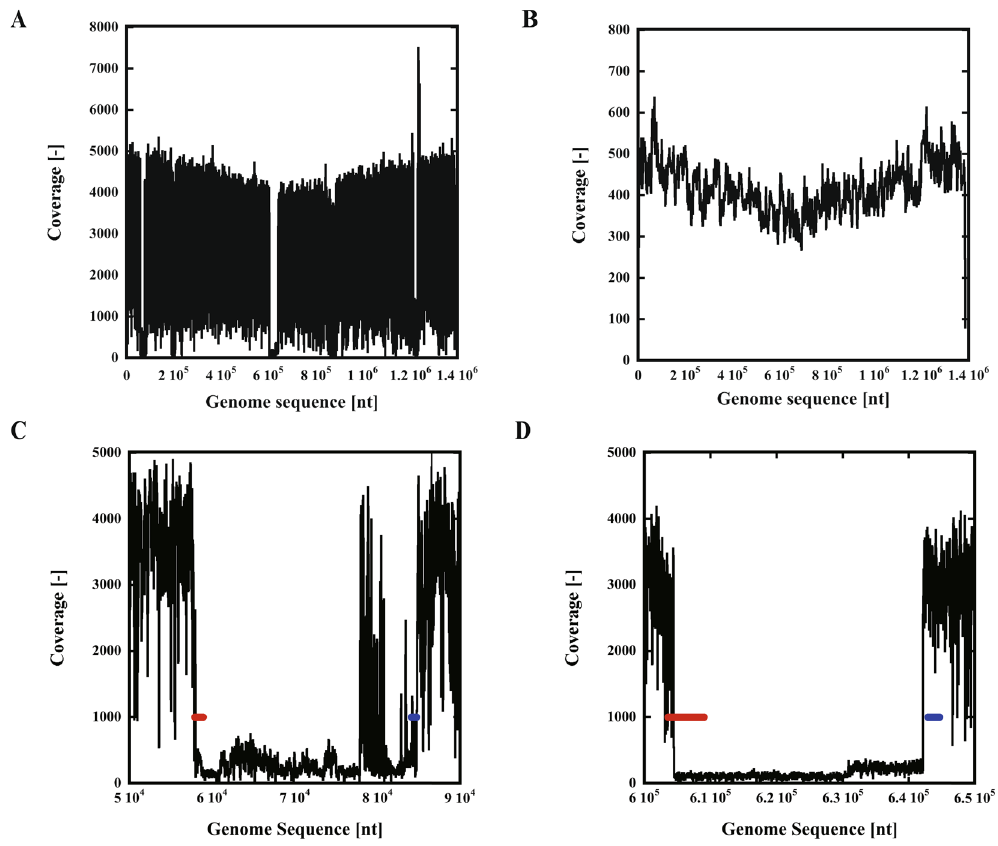
Figure 5. Comparison of the genome sequence of D. mccartyi UCH-ATV1 with the metagenome analysis data. The genome sequence of D. mccartyi UCH-ATV1 was compared with metagenomic data of the original consortium obtained by SOLiD 3 Plus ( A ) or the constructed consortium obtained by PacBio RS II ( B ). ( C , D ) Two large gap regions in comparison to the metagenome data of the original consortium ( A ) are shown. Red and blue lines represent phage- or recombinase-related genes, respectively.